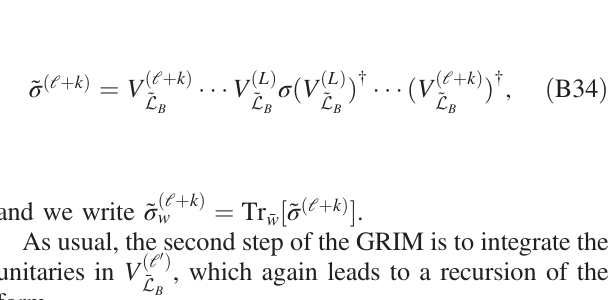
. (b) The unitary W is in the second sublayer but not in its edge. The backward light-cone init